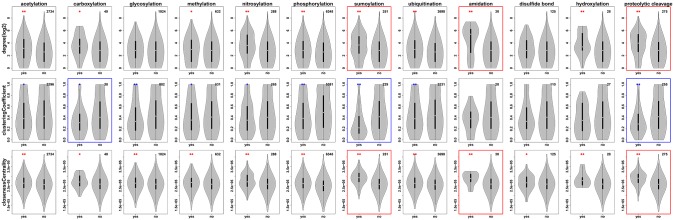
Protein interaction network properties of proteins associated with different PTM-types in Homo sapiens.The network property values of proteins annotated to undergo a particular PTM-type or not are shown by violin plots. The number at the top right corner of each graph represents the number of proteins with the corresponding PTM-type and valid network property definitions in Homo sapiens. Protein interactions were taken from the STRING database. The total numbers of proteins and associated number of interactions in Homo sapiens with confidence score>=0.9 were 8,949 and 71,153, respectively. The red (blue) asterisks at the top of violin plot represents the corresponding PTM group has a significantly higher (lower) median value compared to the non-PTM group (*: p-value 0.05, **: p-value 0.01) by Mann-Whitney test with FDR correction. The top 3 PTMs which have high percentage of median difference between PTM group and non-PTM group for each network property are highlighted with red (increased) or blue (decreased) margin.